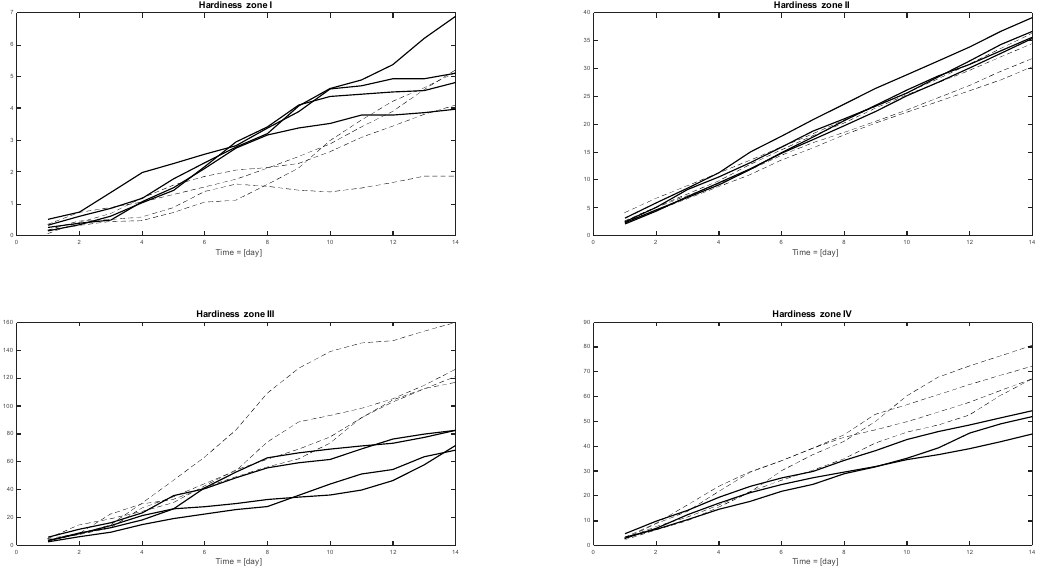
Figure 6. The cumulative summed feature values (y-axis) generated from weather data of the different hardiness zones. The category 0 data (four years’ data in hardiness zones I, II and III, three years’ data in hardiness zone IV) are marked with a solid line and the category 2 data (four years in each hardiness zone) with a dashed grey line. The observation period is 14 days, t 0 is the beginning of growing season, and the time step is one day.